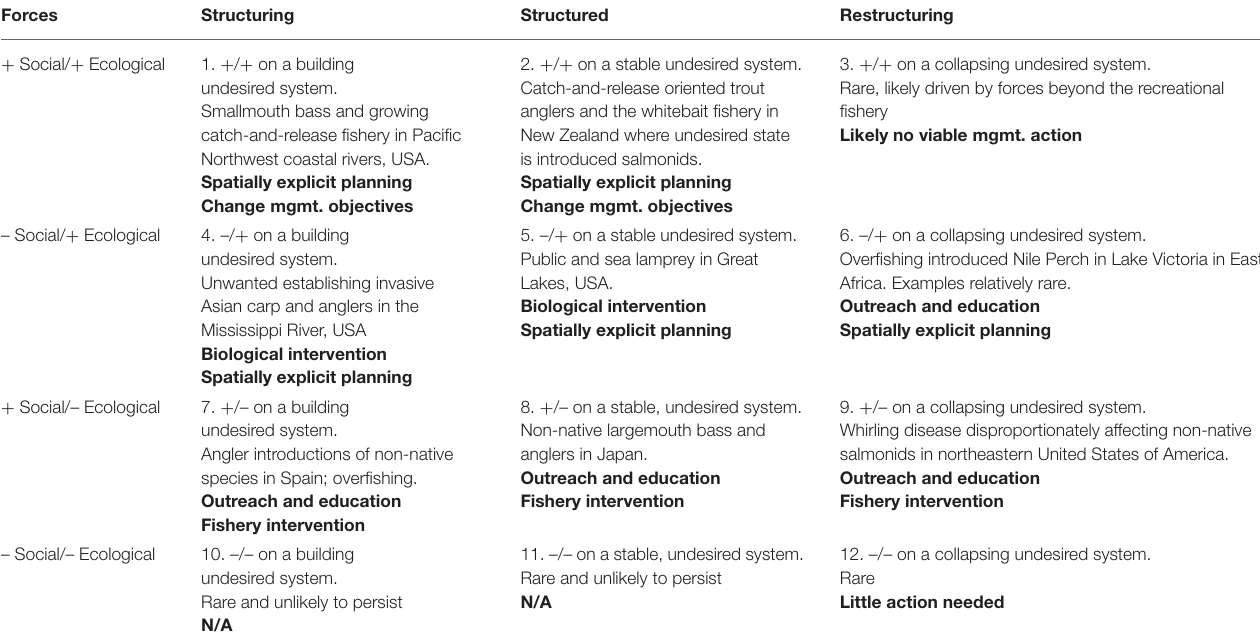
TABLE 3 | Examples and likely viable management strategies for socioecological forces (rows) and resilience stages (columns) relevant for an undesired management focus.